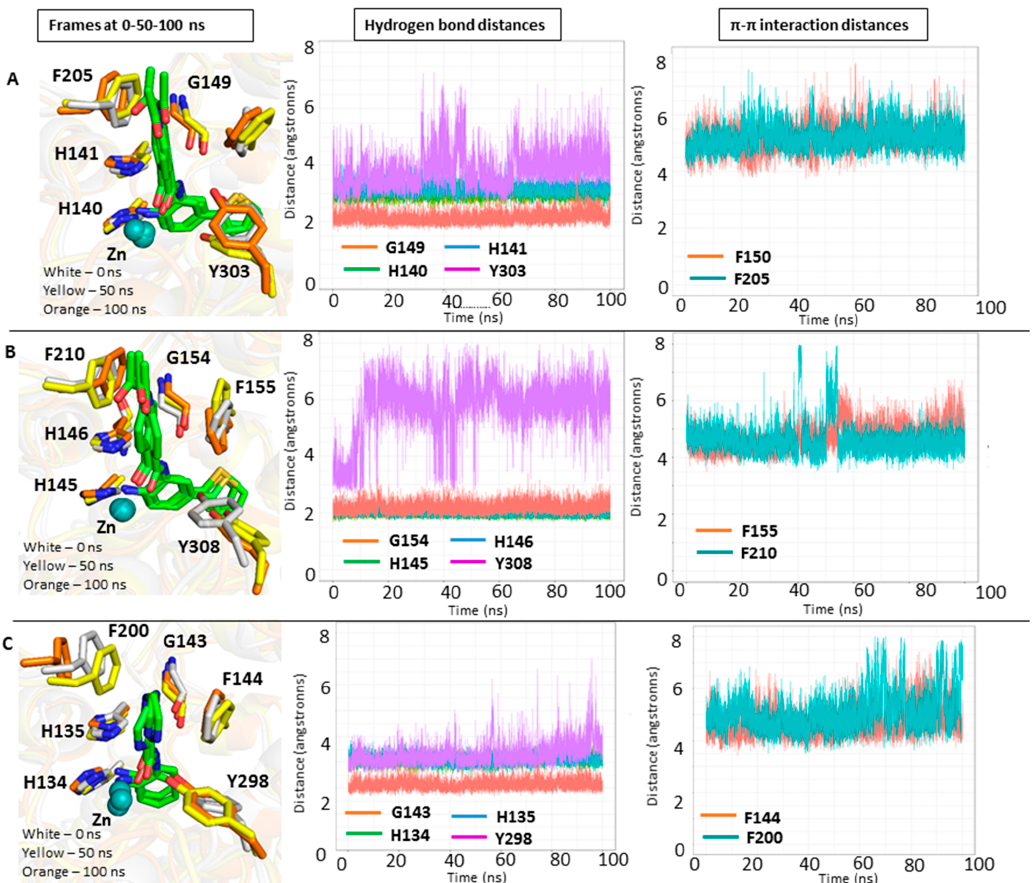
Figure 3. Results of the MD simulations of HDAC1, 2, 3 in complex with inhibitors. Shown are the frames of the MD simulations at 0 ns (white carbon atoms), 50 ns (yellow carbon atoms), and 100 ns (orange carbon atoms) on the left side. In the middle, distance analysis of specified hydrogen bonds between inhibitor and HDAC are shown. On the right side, the distance analysis of aromatic π – π interactions between inhibitor and HDAC are shown. HDAC1 ( A ), HDAC2 ( B ), HDAC3 ( C ). Zinc ions are shown as cyan spheres. Ligands are shown in stick representation and their carbon atoms are colored green in HDAC1, HDAC2 and HDAC3. For clarity, only relevant amino acid residues are